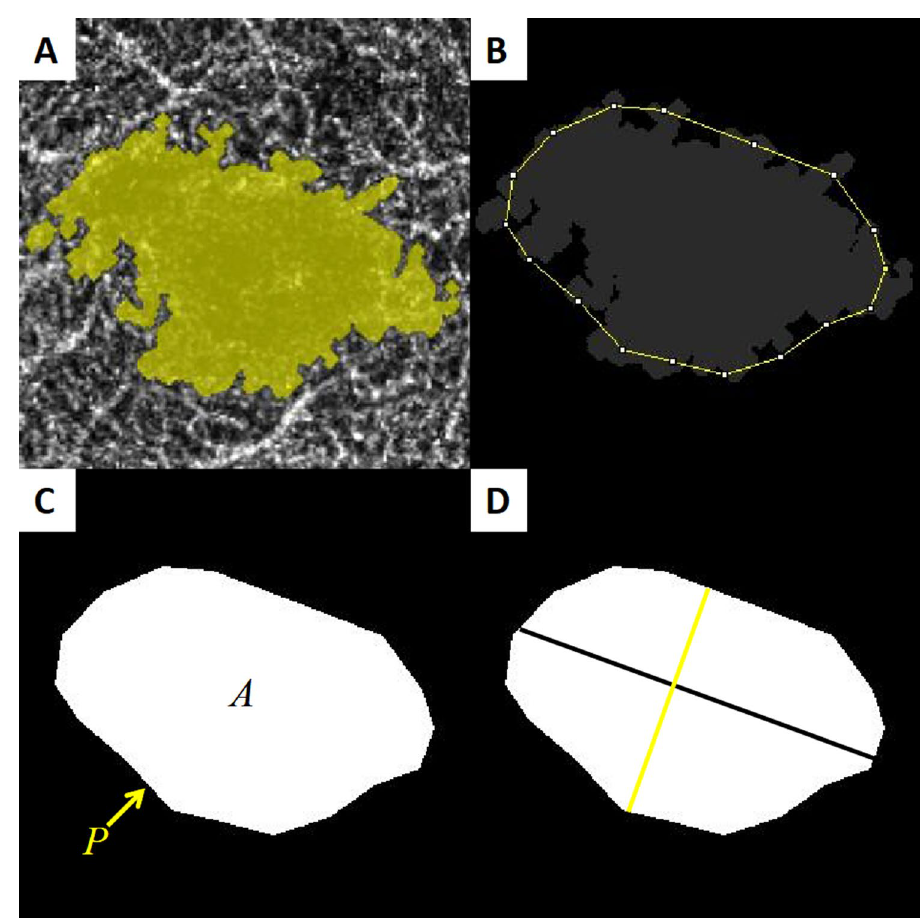
Figure 4. ( A ) Optical coherence tomography angiogram of the foveal avascular zone (FAZ) in deep layer. ( B ) An irregular outline was manually fit using the ImageJ software. ( C ) The FAZ area ( A ) and perimeter ( P ) were automatically measured using the ImageJ software after outlining the FAZ. ( D ) The major axis (black line) and minor axis (yellow line) lengths were manually